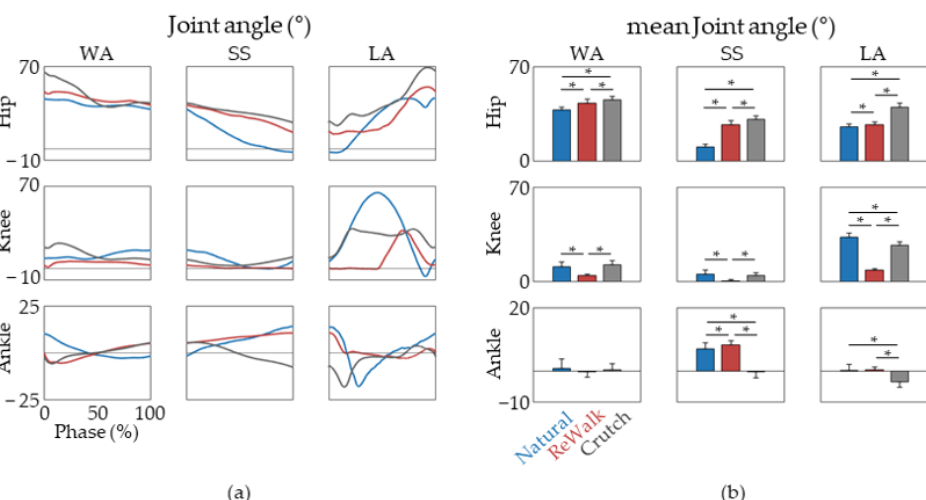
Figure 4. Comparison of joint angles in subject 1 divided according to the gait-related biomechanical phases. ( a ) Overlay of mean hip, knee, and ankle joint angles during WA, SS, and LA phases obtained from ReWalk (red lines), natural (blue lines), and crutch (grey lines) gait conditions. ( b ) Bar graph representing the average joint angles over the WA, SS, and LA phase periods. The data are shown as mean ± SD. Statistical significance was assessed by independent two sample t -tests (* denotes p < 0.05).